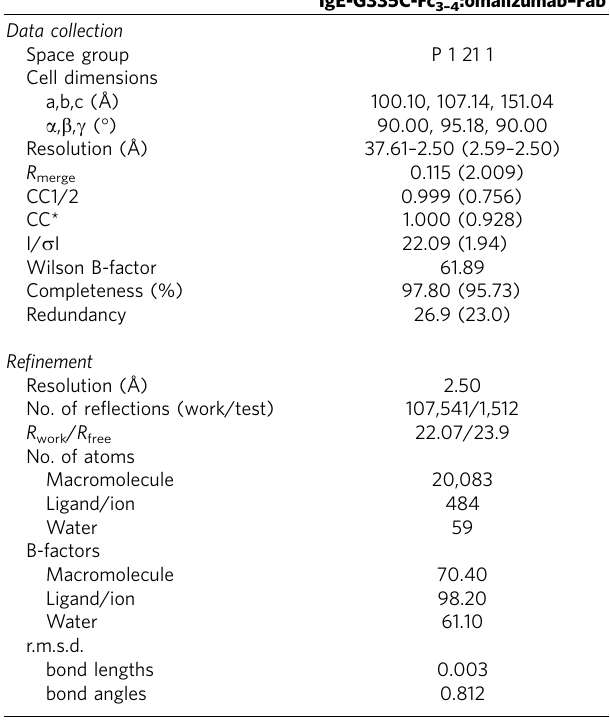
IgE-G335C-Fc 3–4 :omalizumab–Fab